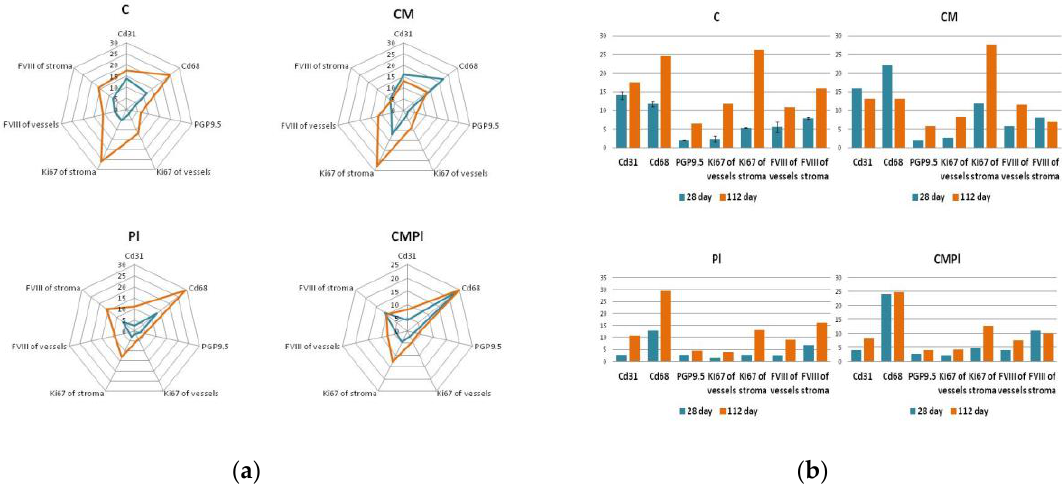
Figure 5. Immunohistochemical study of animal skin defects: ( a ) Absolute number of IHC markers in excised animal skin defect tissue samples per 10 visual fields; ( b ) semiquantitative assessment of the expression of IHC markers in excised animal skin defect samples (with a score from 0 to 3, where 0 is the absence of expression and 3 is full expression). (C: irradiated rats without subsequent therapy, CM: irradiated rats that received intradermal administration of culture medium (MesenCult) concentrate, PL: therapy of LRI using MSC derived from the placenta, CMPL: therapy of LRI using a concentrate of conditioned medium collected from culture of the MSCs. Blue: 28 days; orange: 112 days from the start of therapy. The score is from 0 to 3, where 0 is the absence of expression and 3 is full expression.).